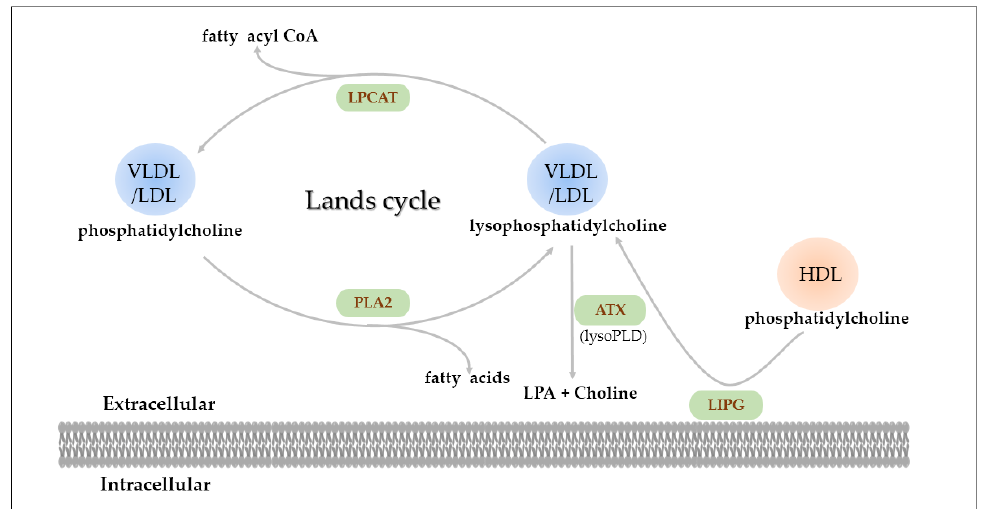
Figure 5. Degradation of phosphatidylcholine and lysophosphatidylcholine with involved key enzymes (VLDL, very low-density lipoprotein; LDL, low-density lipoprotein; HDL, high-density lipoprotein; LPA, lysophosphatidic acid; PLA2, phospholipase A2; LPCAT, lysophosphatidylcholine acyltransferase; ATX, autotoxin; LIPG, endothelial lipase). Human lipoproteins, including very low-density lipoprotein (VLDL), low-density lipoprotein (LDL), and high-density lipoprotein (HDL), contain PC and LPC. The Lands cycle is a circulation mechanism for the synthesis and degradation of PC and LPC